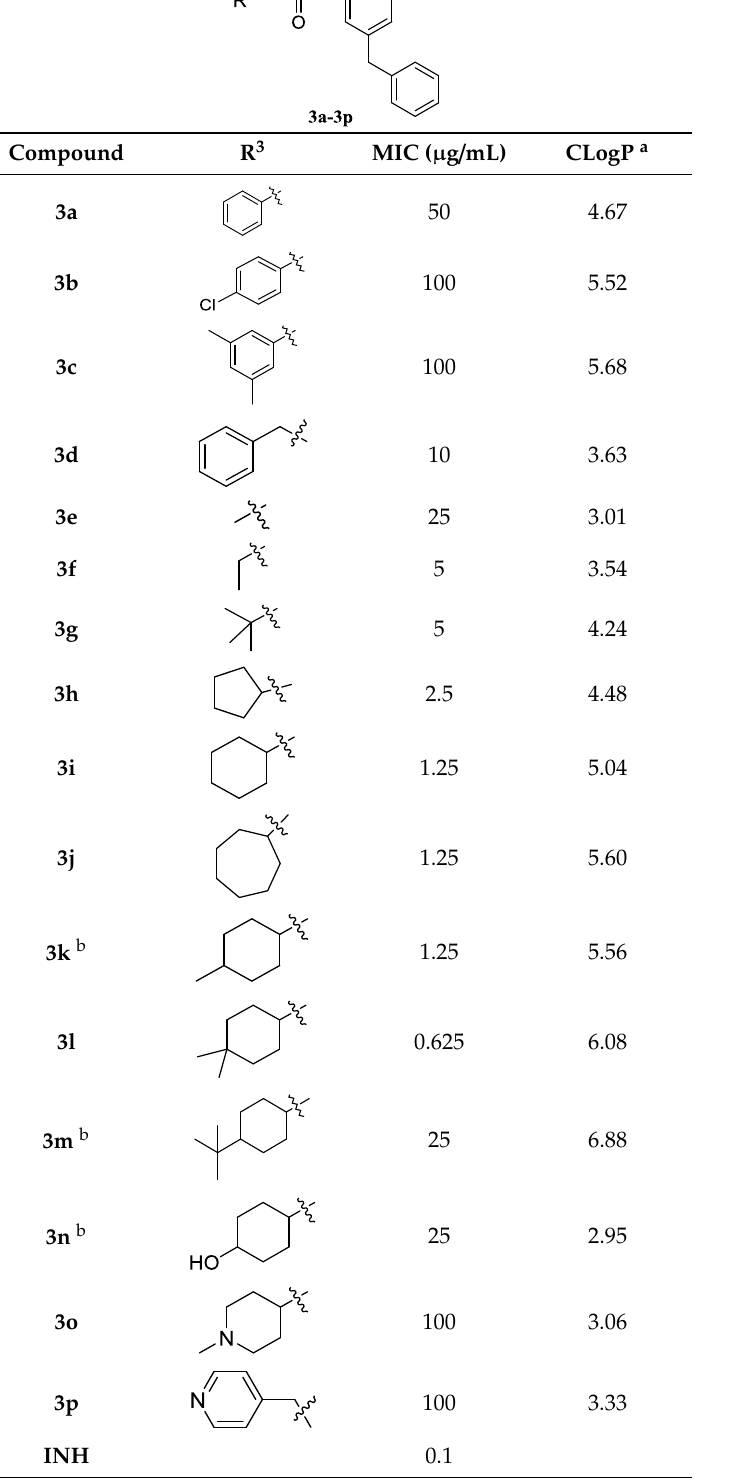
Table 3. In vitro inhibitory activity of 3q – 3r against Mtb H37Ra.